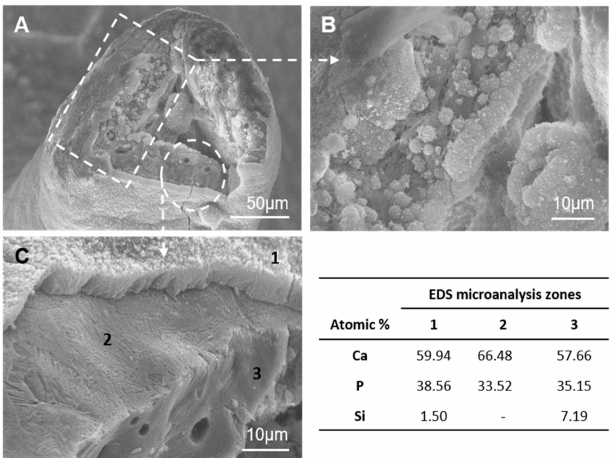
Figure 6. SEM micrographs at different magnifications of a broken scaffold strut after 28 days in GM with ah-MSCs: ( A ) the broken strut, ( B ) detail of a globular niche produced after collagen-like fibril formation and ( C ) detail of three well-defined consecutive